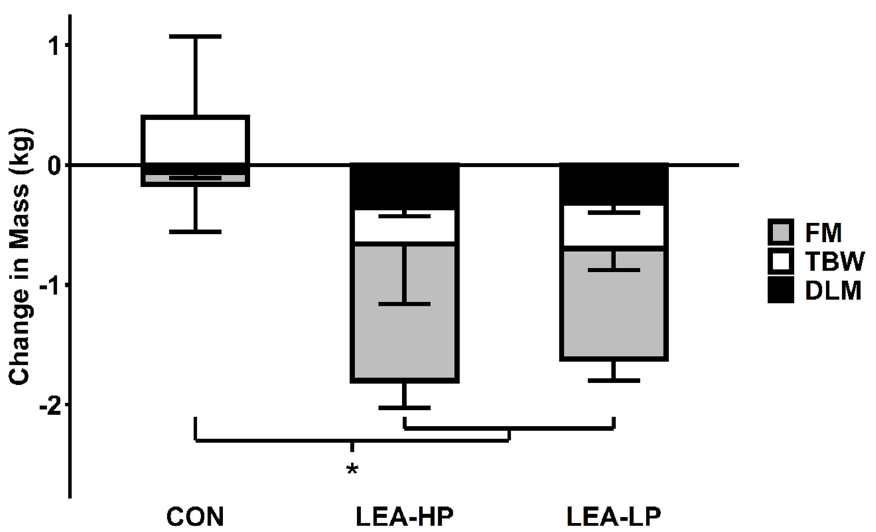
Figure 1. Changes in body composition by condition. Abbreviations: FM, fat mass; TBW, total body water; DLM, dry lean mass; CON, control; LEA-HP, low energy availability with high protein; LEA-LP, low energy availability with low protein. * indicates p < 0.05 LEA vs. CON for each compartment. Table 2. Biomarker responses to each condition